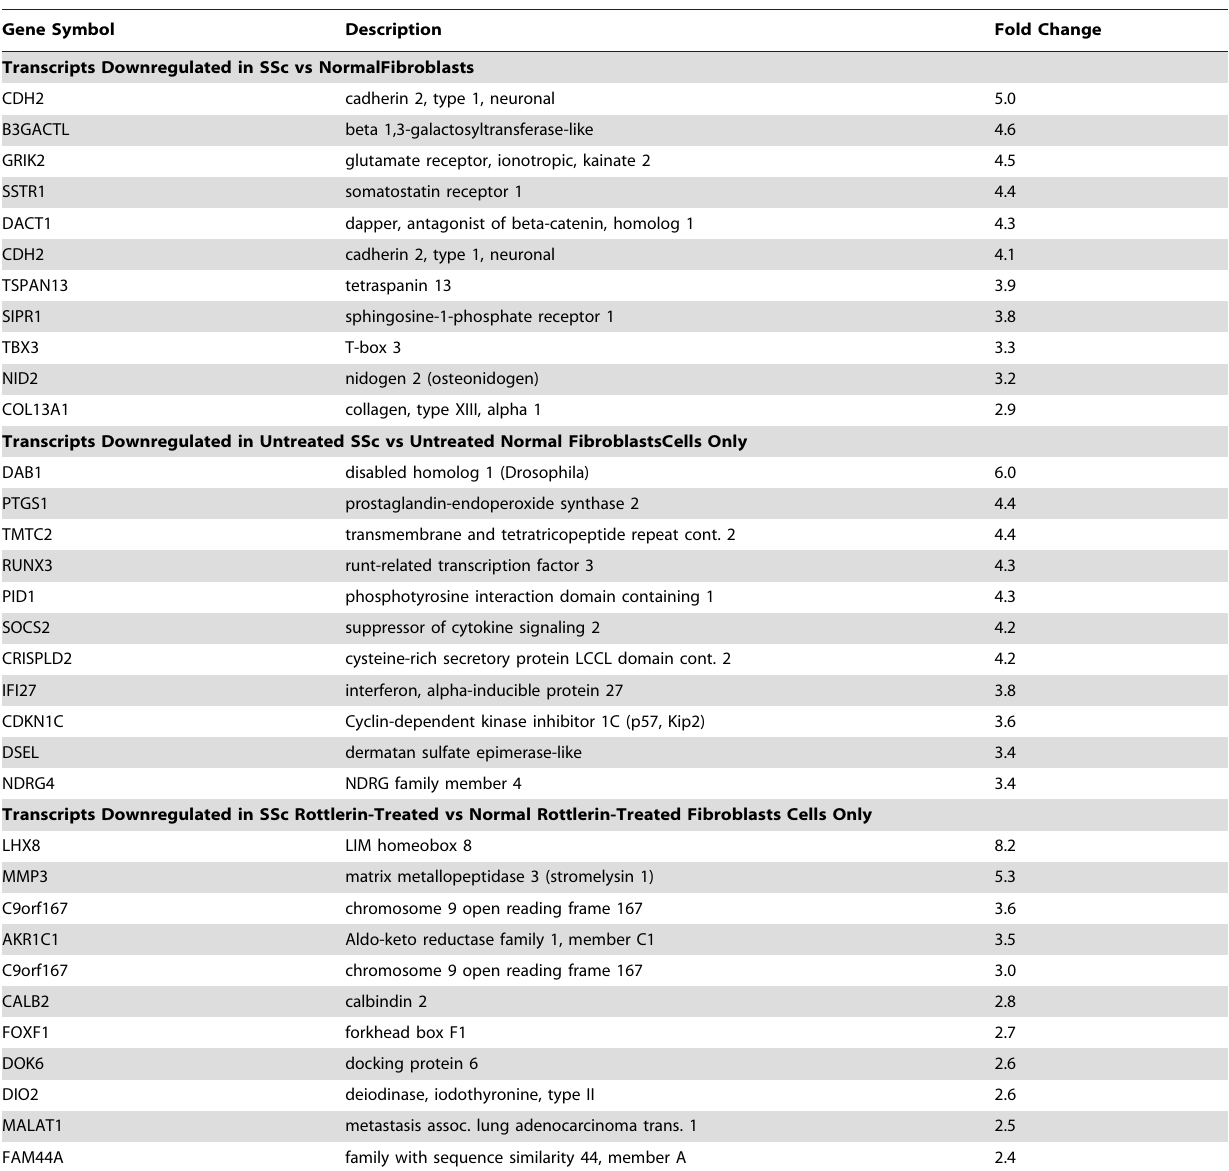
Table 7. Selected transcripts downregulated in SSc fibroblasts.